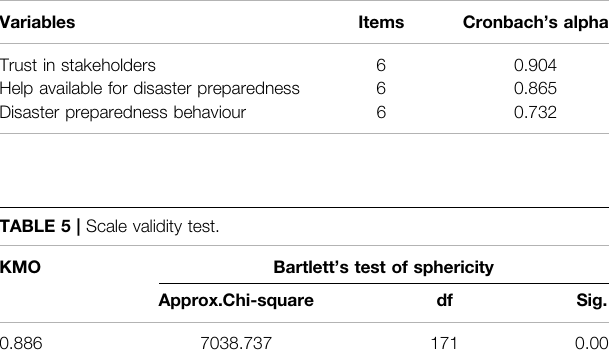
TABLE 3 | Socio-demographic information of